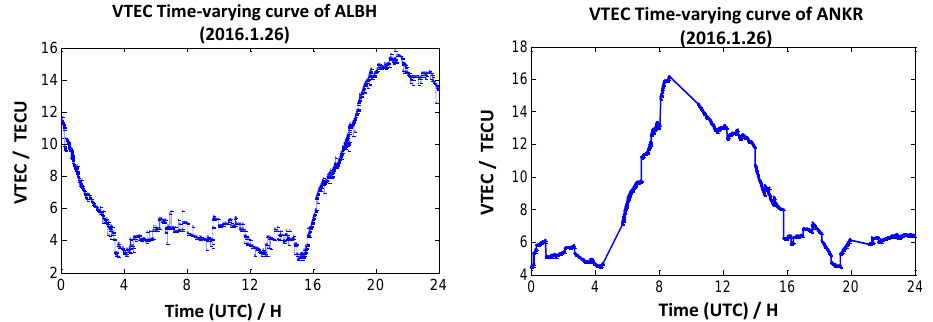
Figure 2. Vertical total electron content (VTEC) time-varying curve of station ALBH and station ANKR.